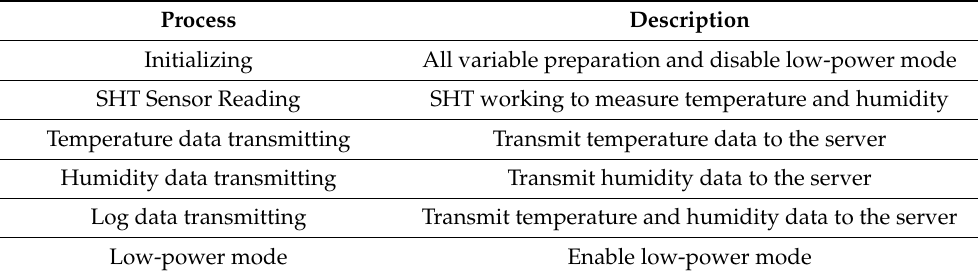
Table 12. Wireless climate sensor node working processes.